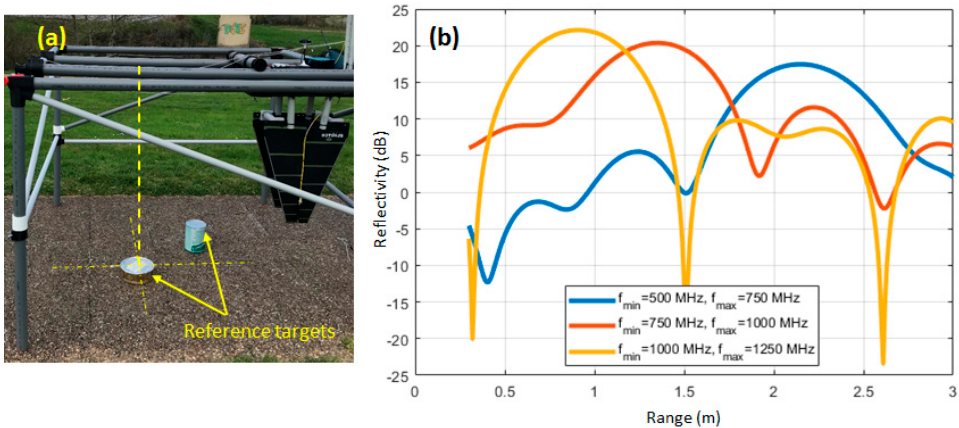
Figure 15. Phase center compensation for the LPA. Picture of the measurement setup with the metallic reference objects ( a ). Reflectivity along z -axis (range) for a position located on top of a flat metallic object ( b ). Sub-bands of 250 MHz ( ∆ R = 60 cm) are considered.